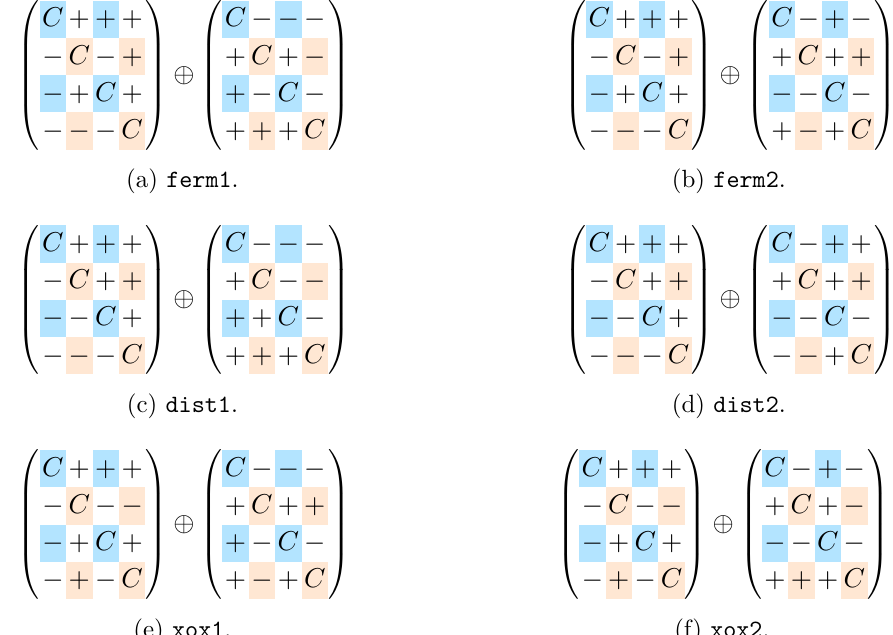
Figure 1 : Structure of an element in psu (1 , 1 | 2) ⊕ 2 . The blue and red elements each generate a psu (1 | 1) ⊕ 2 subalgebra. After deformation the symmetry algebra is promoted to a quantum group associated to the Cartan-Weyl basis ( C, + , − ) where C denotes the Cartan elements, + denotes the positive roots and − denotes the negative roots. The choice of Cartan-Weyl basis differs for the different deformations. When going from ferm1 to ferm2 (or dist1 to dist2 , xox1 to xox2 ), positive and negative roots are exchanged in the second copy. The two deformations are thus related by an inversion q